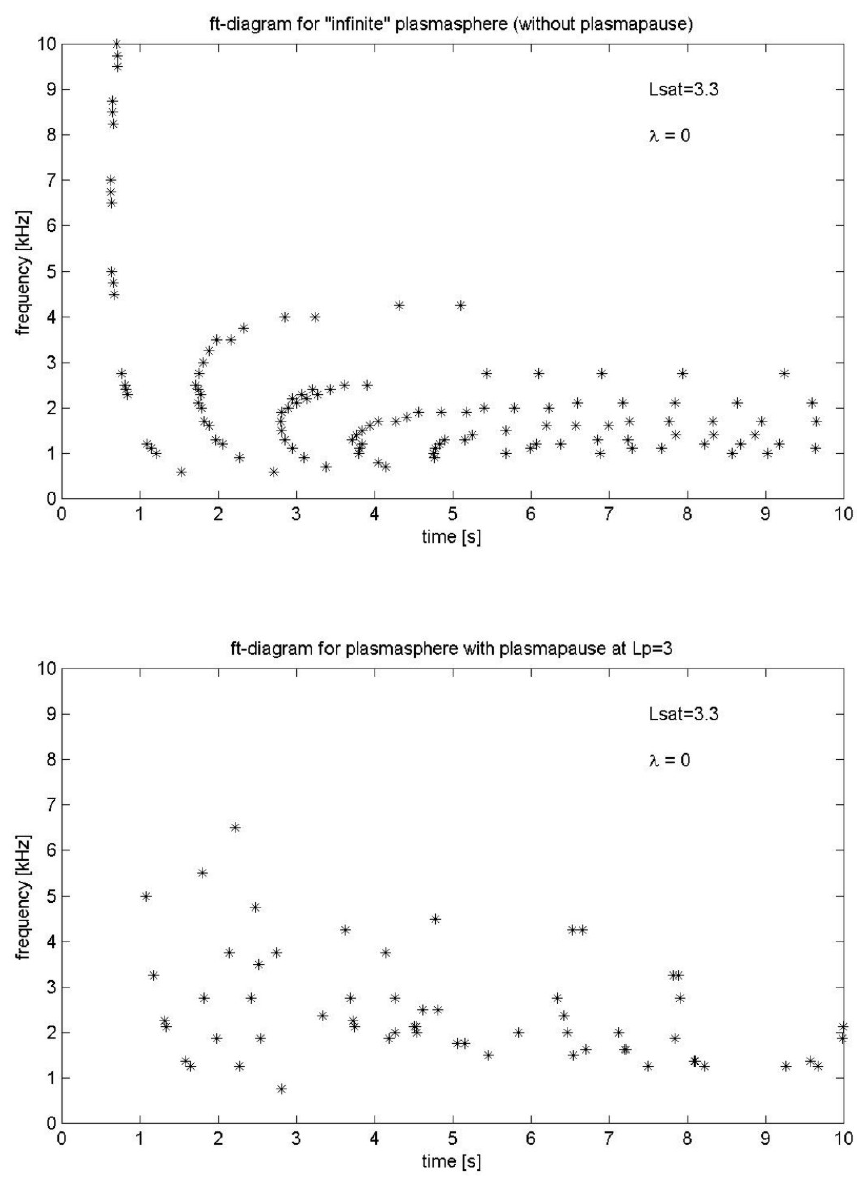
Fig. 11. Comparison of simulated MR whistler spectrograms with (lower panel) and without (upper panel) tak- ing into account the plasmapause, in the case when a satellite is above the